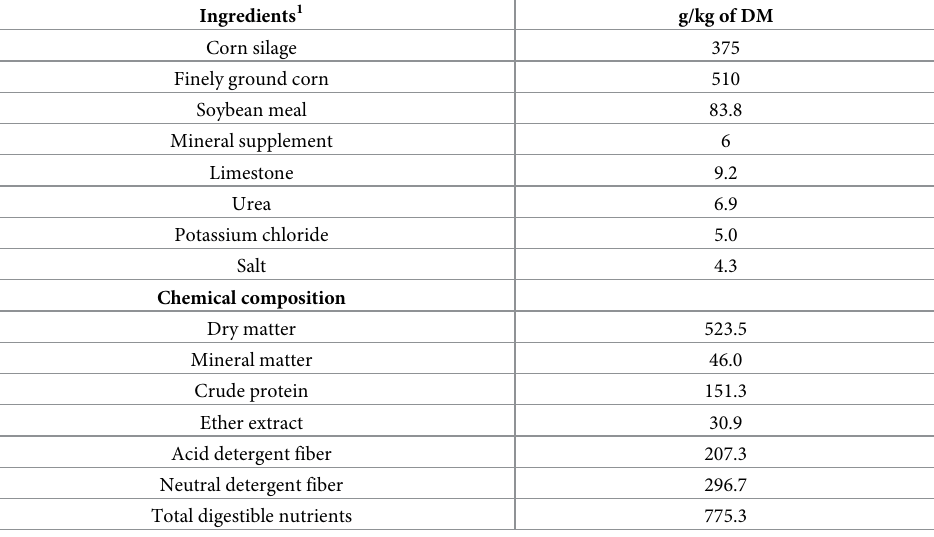
Table 1. Ingredients and chemical composition on a dry matter (DM) basis (g/kg) of final